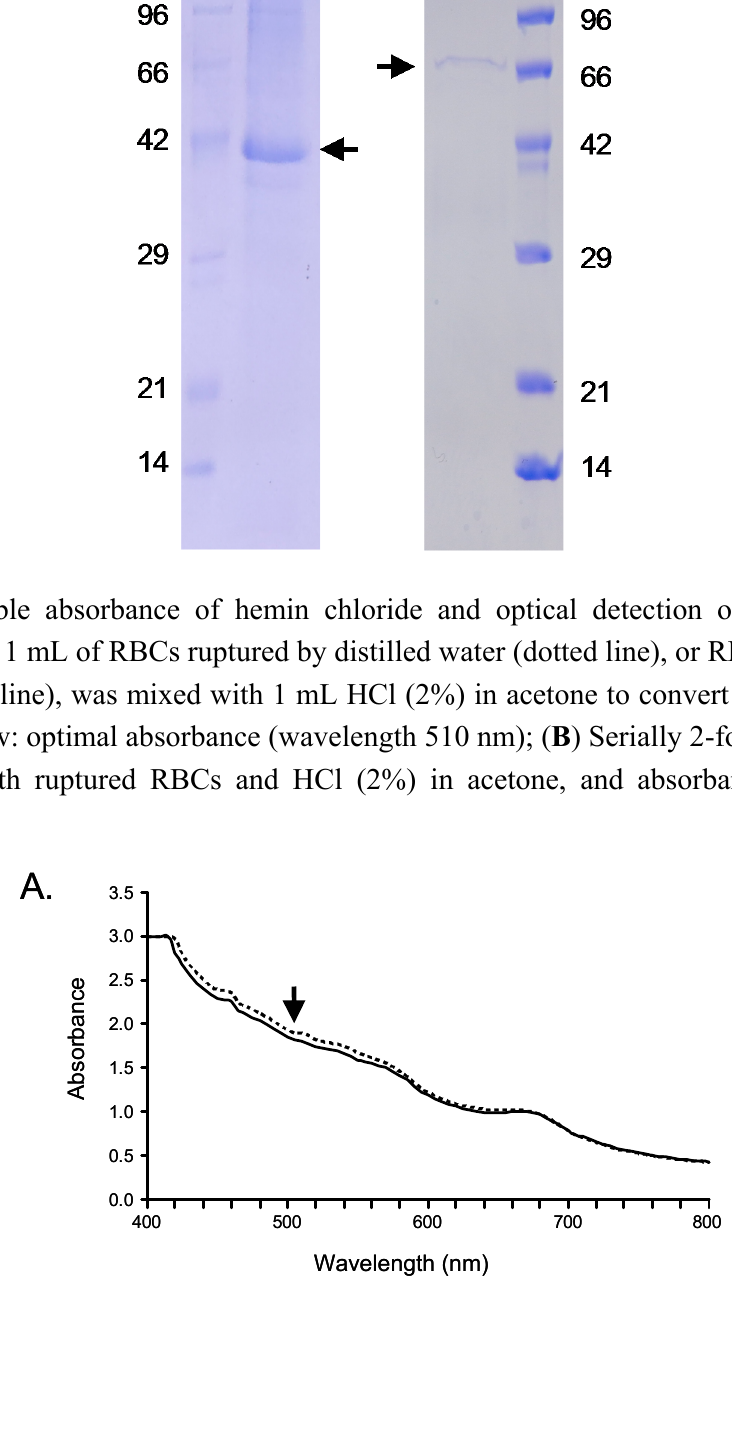
serum albumin (66 kDa), ovalbumin (42 kDa), carbonic anhydrase (29 kDa), trypsin inhibitor (21 kDa), and lysozyme (14 kDa).